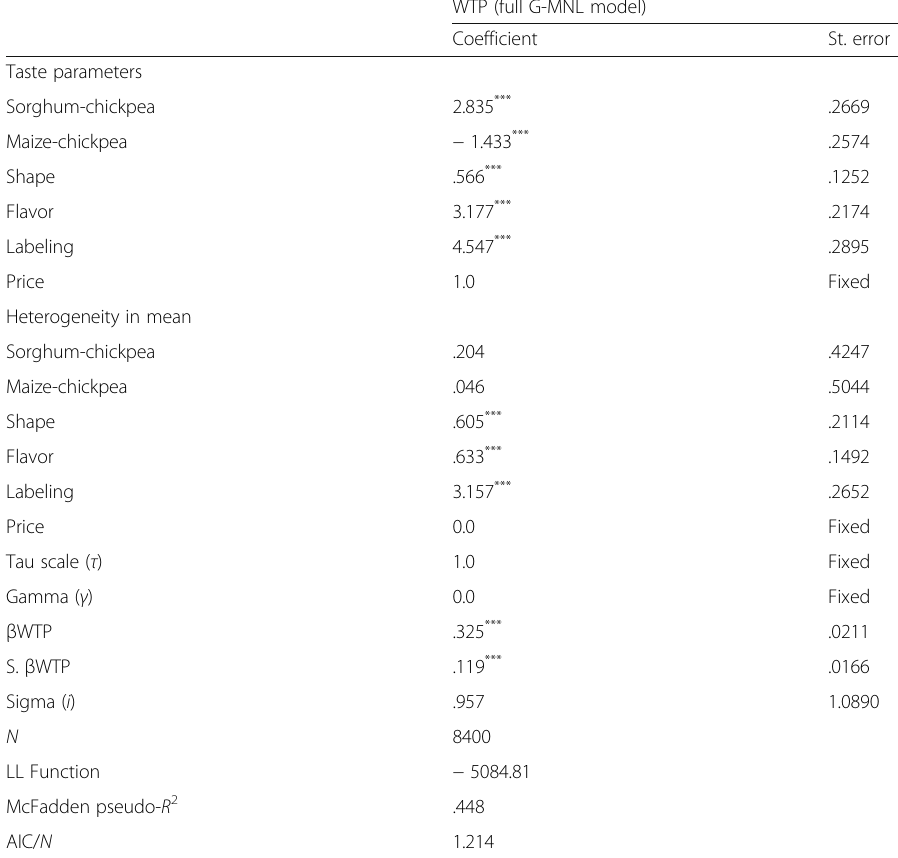
Table 7 Willingness to pay for enriched snack product traits in willingness to pay space WTP (full G-MNL model) Coefficient St.